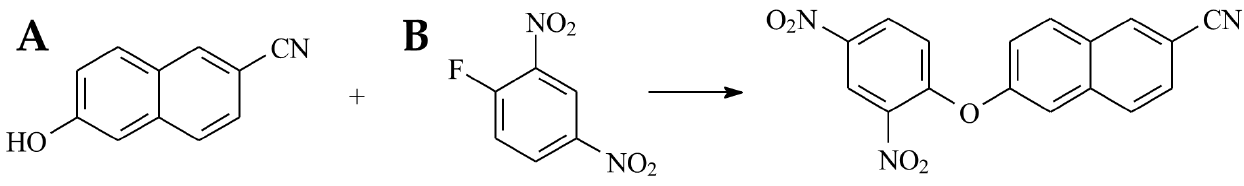
Figure 3. Fluorescent probe synthesis from ( A ) 6-hydroxy-2-naphthonitrile and ( B ) 1-fluoro-2,4-dinitrobenzene. Samples of 6-hydroxy-2-naphthonitrile ( A ) (1.075 g, 6.4 mmol) and